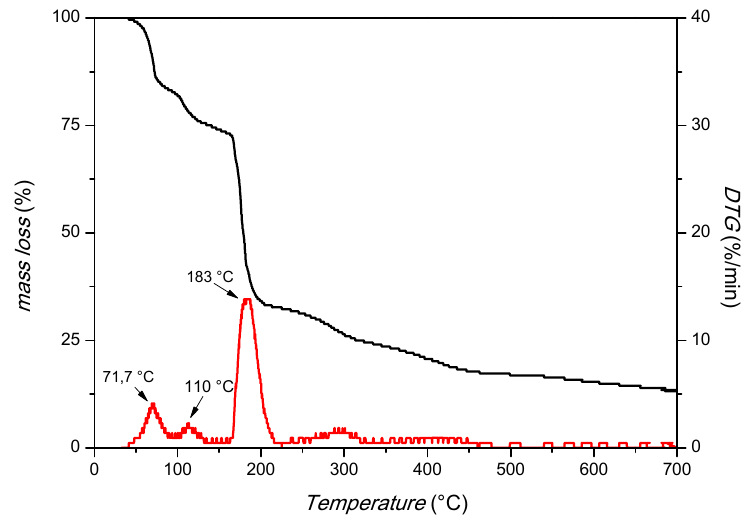
Figure 2. TGA analysis of MIL-88A (airflow of 100 cm 3 /min and a heating rate of 10 °C/min). In addition, the BET surface area of 9.9 ± 0.2 m 2 /g (Figure 3) is in line with the result obtained in the literature for MIL-88A under similar preparations [40,41]. The material is microporous, as expected, and the BET diagram shows an isotherm resembling type IV with a little pronounced hysteresis of type H3. The synthesized catalyst pores diameter < 2 nm (in the structure the diameter is about 10 Å [42]), as shown by BJH analysis (Figure S2), where no pores are present in the range from 5 to 50 nm.